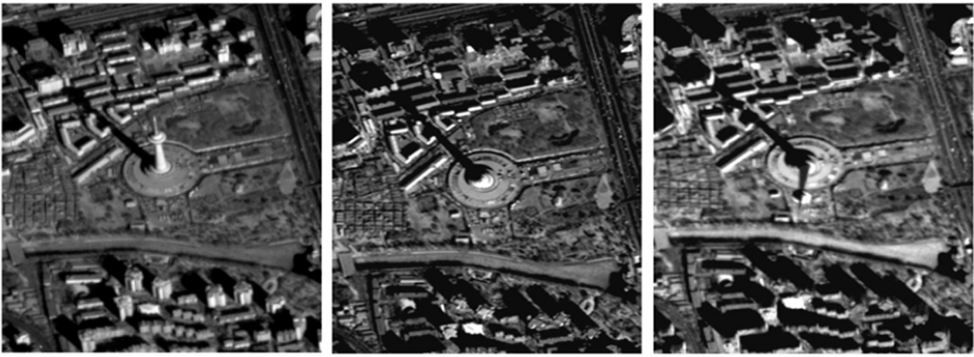
Figure 1. Simultaneous-phase three-line-array remote-sensing images.